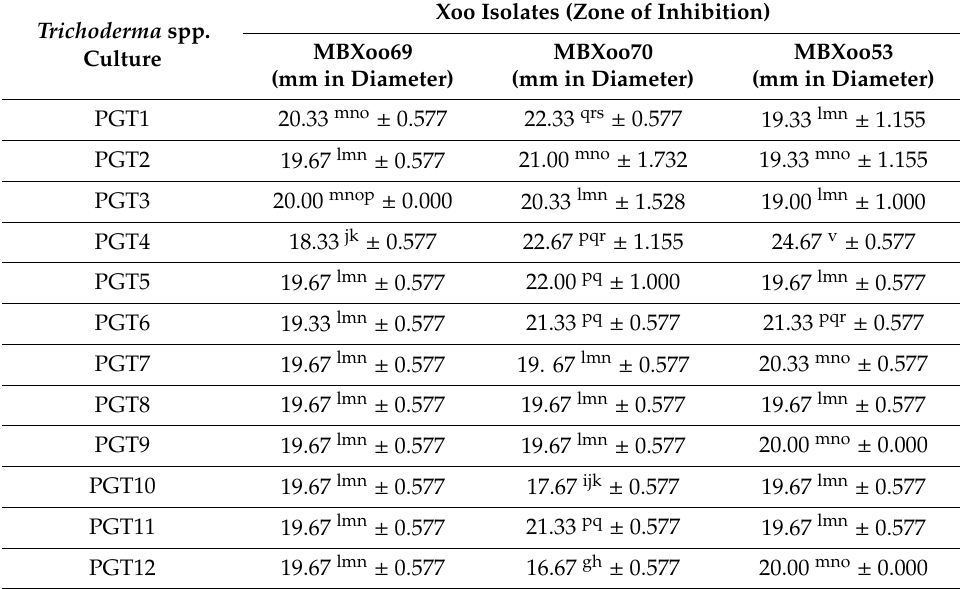
Table 1. Antibacterial activity of Trichoderma spp. isolated from rhizosphere soil on screening against Xanthomonas oryzae pv. oryzae (Xoo) (Mean ± standard deviation). Trichoderma